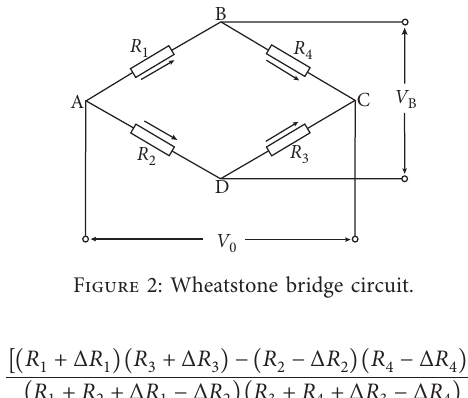
Figure 2: Wheatstone bridge circuit.